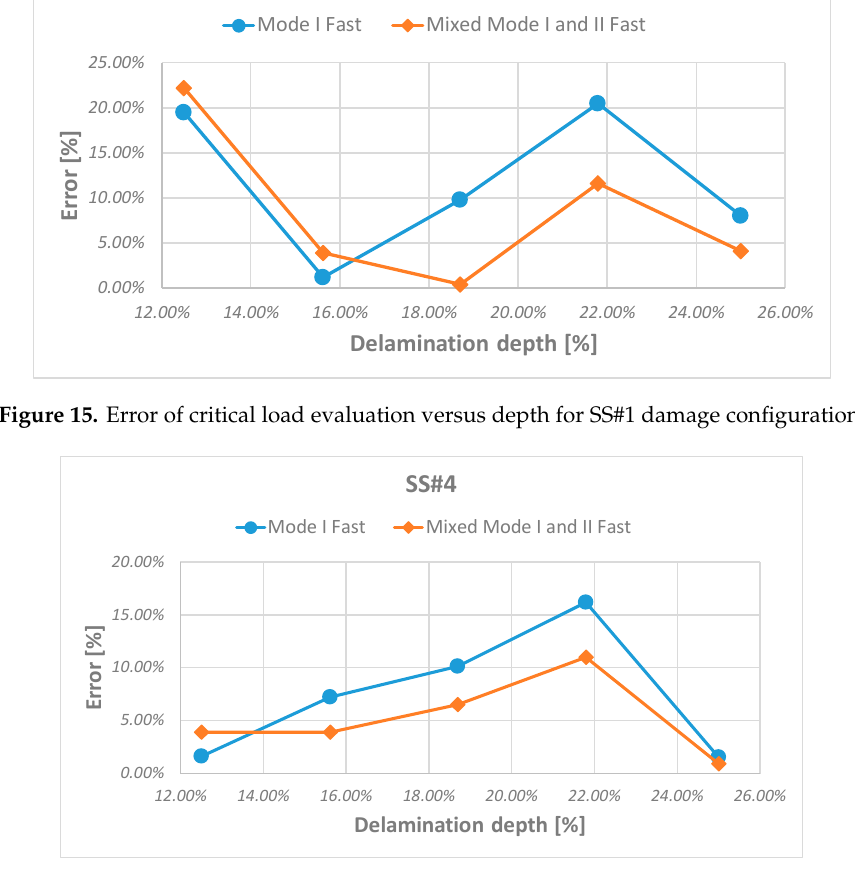
Figure 16. Error of critical load evaluation versus depth for SS#4 damage configuration.